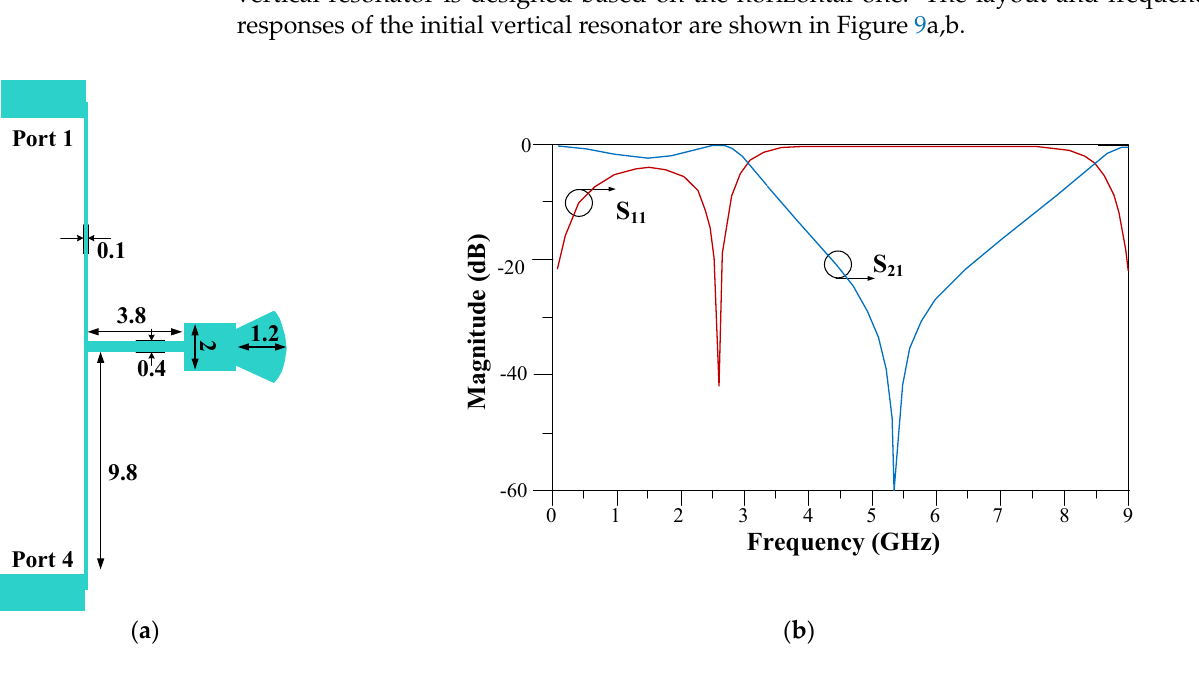
Figure 9. Initial vertical resonator: ( a ) layout and ( b ) frequency response. All dimensions are in the millimeter unit.